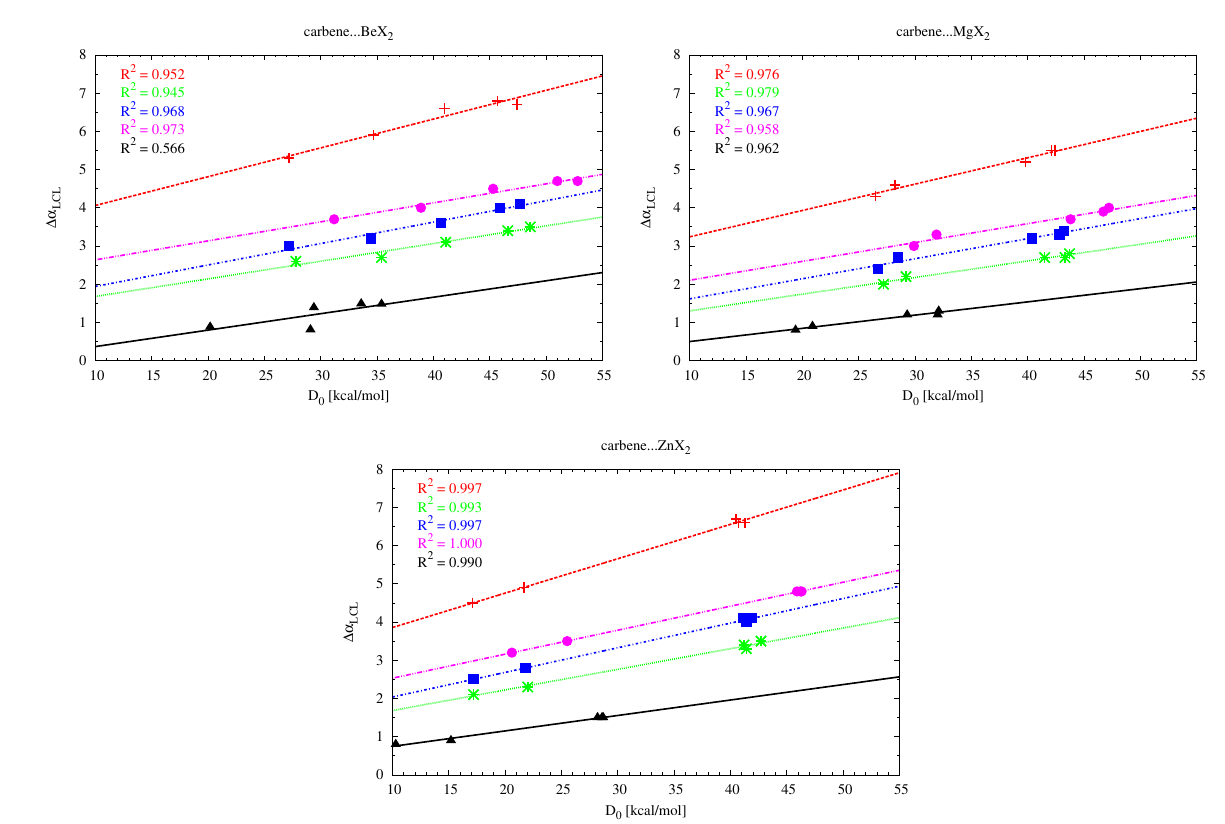
Figure 8. Relationships between the change of the LCL opening angle ( ∆ α LCL ) and the dissociation energy ( D 0 ) of the L 2 C · · · MX 2 dimers, where L 2 C = (NH 2 ) 2 C (red), imidazol-2-ylidene (green), imidazolidin-2-ylidene (blue), tetrahydropyrymid-2-ylidene (magenta), cyclopropenylidene (black).